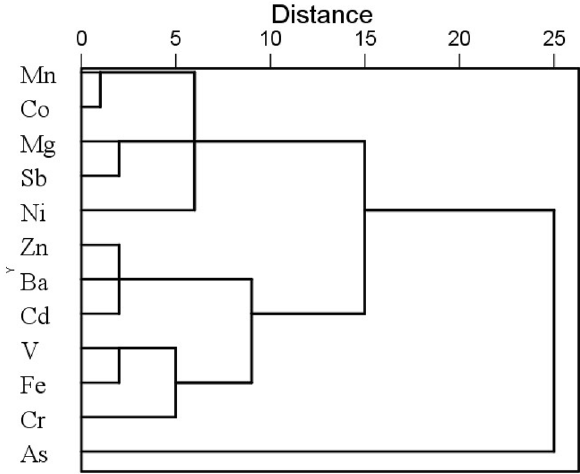
Figure 4. Cluster analysis dendrogram of metals in surface